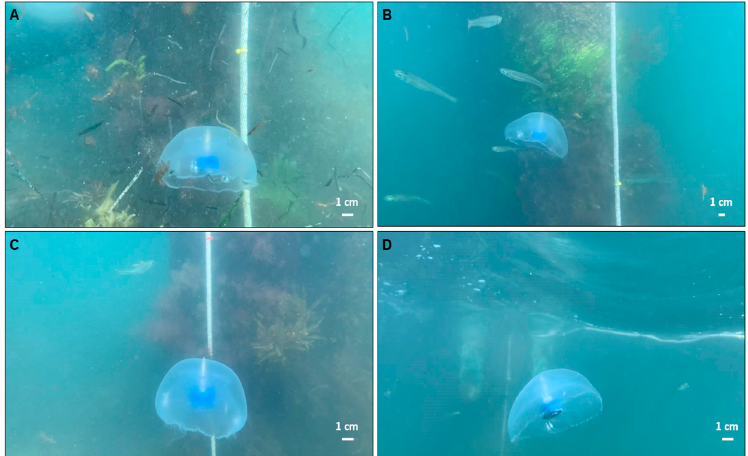
Figure 3. Representative images of biohybrid robotic jellyfish during field experiments. Examples of one biohybrid robotic jellyfish (animal 1) ( A ) initiated at the ocean bed and stimulated at 0.50 Hz, ( B ) swimming toward the ocean surface at 0.50 Hz, ( C ) initiated at the ocean bed and stimulated at 0.50 Hz (second trial), and ( D ) swimming toward the ocean surface at 0.50 Hz (second